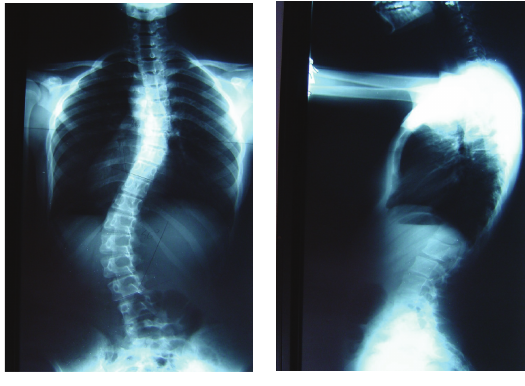
Figure 5: 13 years and 9 months old girl, thoracic Cobb angle 26 ◦ , thoracolumbar Cobb angle 46 ◦ , Risser sign 4. 1.5 years after menar- che. Main curve ATR = 15 ◦ , sum of three ATRs = 20 ◦ , POTSI = 50.2, HS = 18, (a) raster stereography, (b)